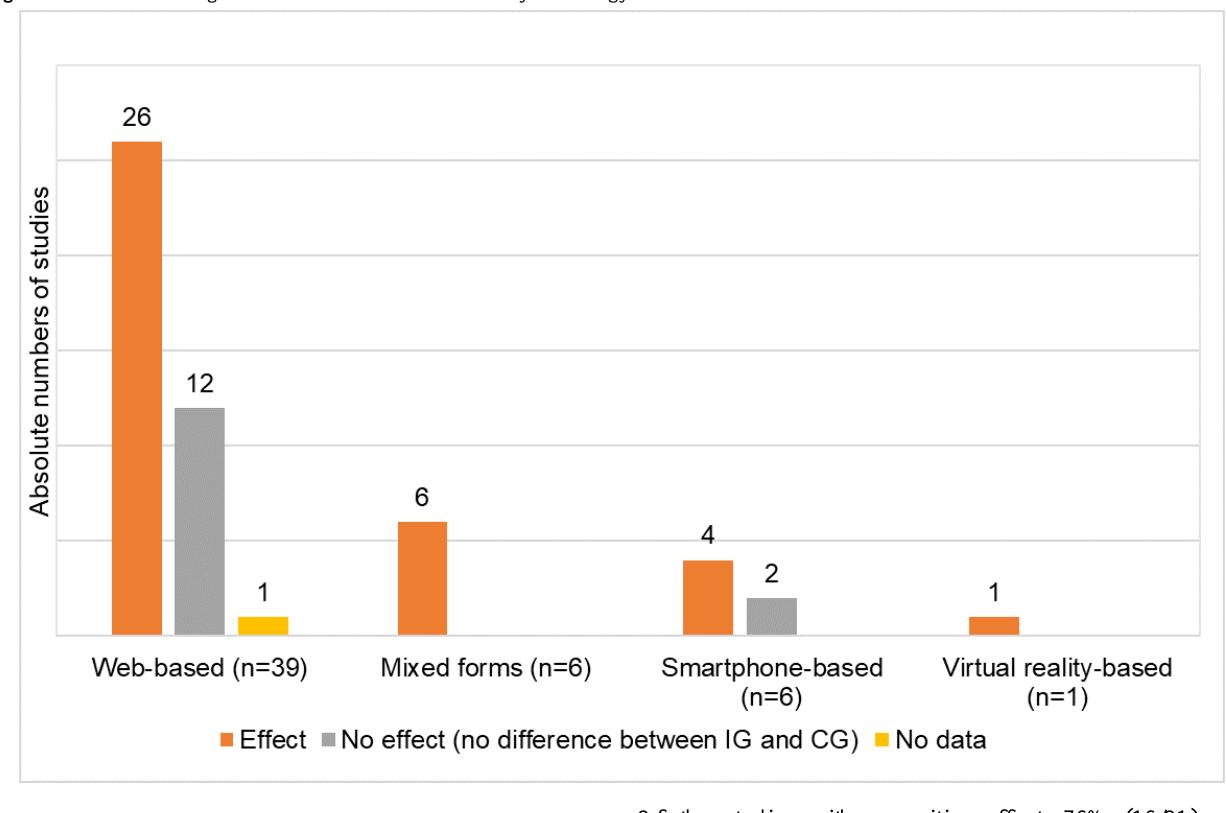
Figure 3. Evidence for digital health interventions classified by